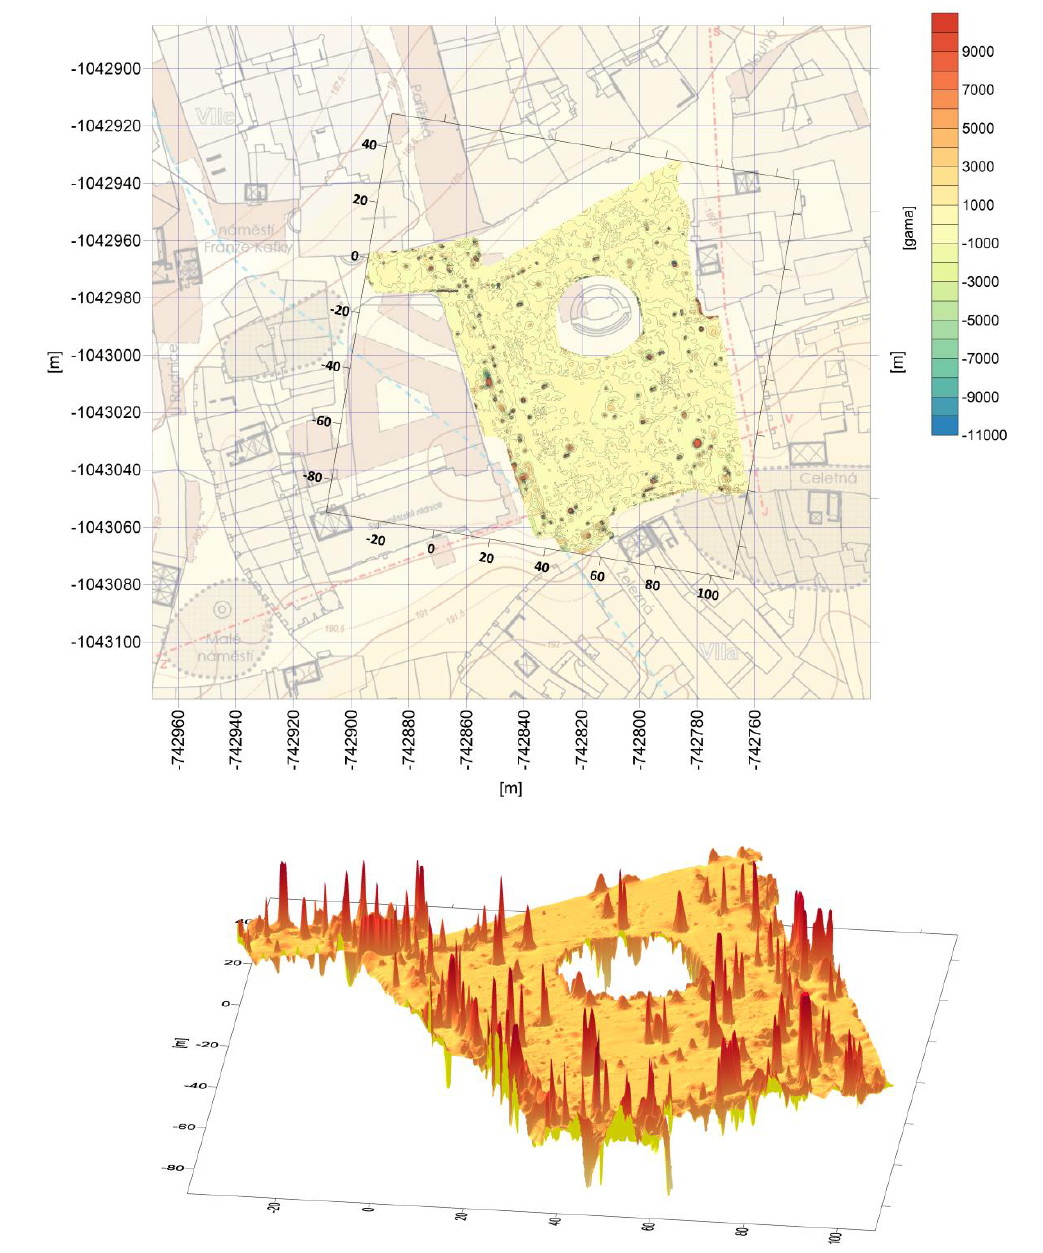
Figure 19. Old Town Square. 2D (above) and 3D (bottom) images of the vertical gradient magnetic field in the unprocessed measured data.